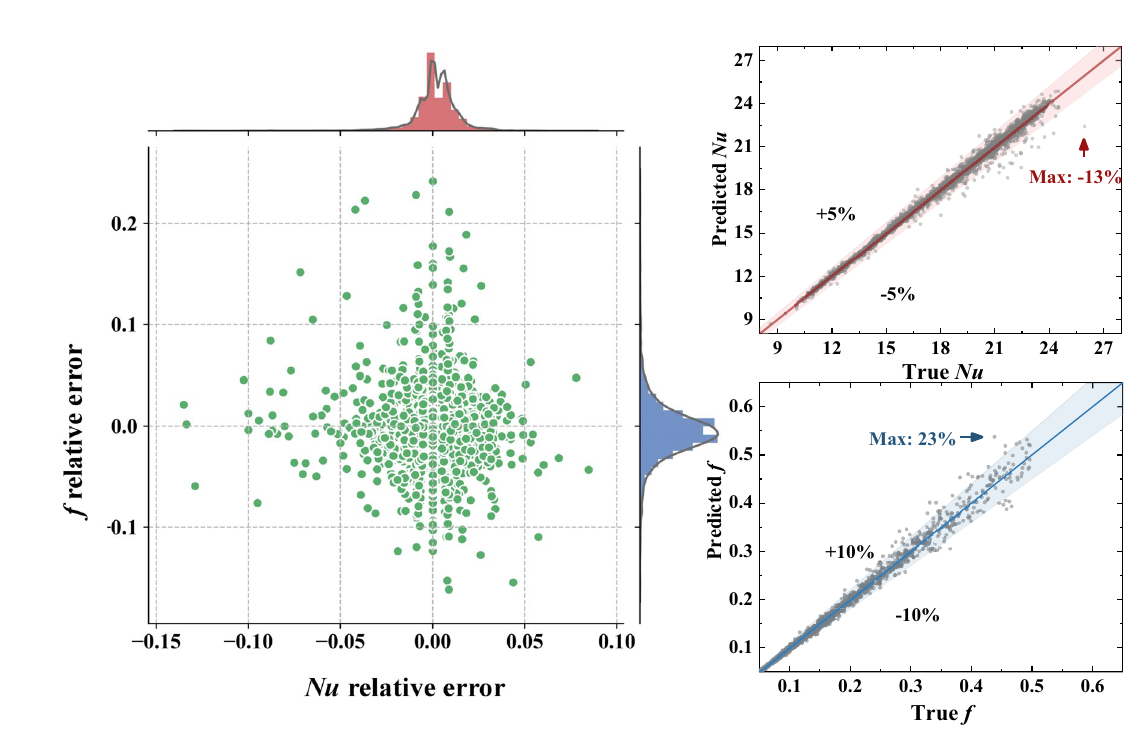
Figure 7. Prediction of thermal and hydraulic